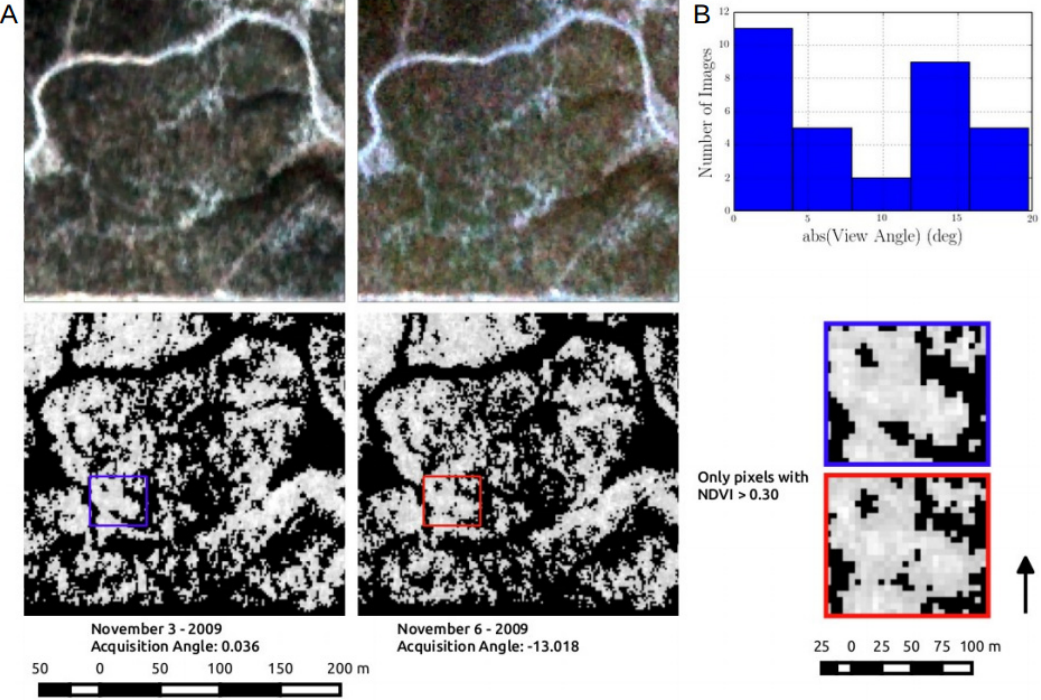
Figure 4. ( A ) RapidEye false color composites of the PJ control site ( top ) for two image dates 3 days apart in 2009, and the corresponding fraction of pixels with NDVI > 0.30 ( bottom ), with detailed subsets on the far right; ( B ) Histogram of view angles that comprised the entire RapidEye time series. View angles are represented as absolute values from nadir. Table 5. Model performance statistics for RapidEye sensor view angles less than 7 degrees off